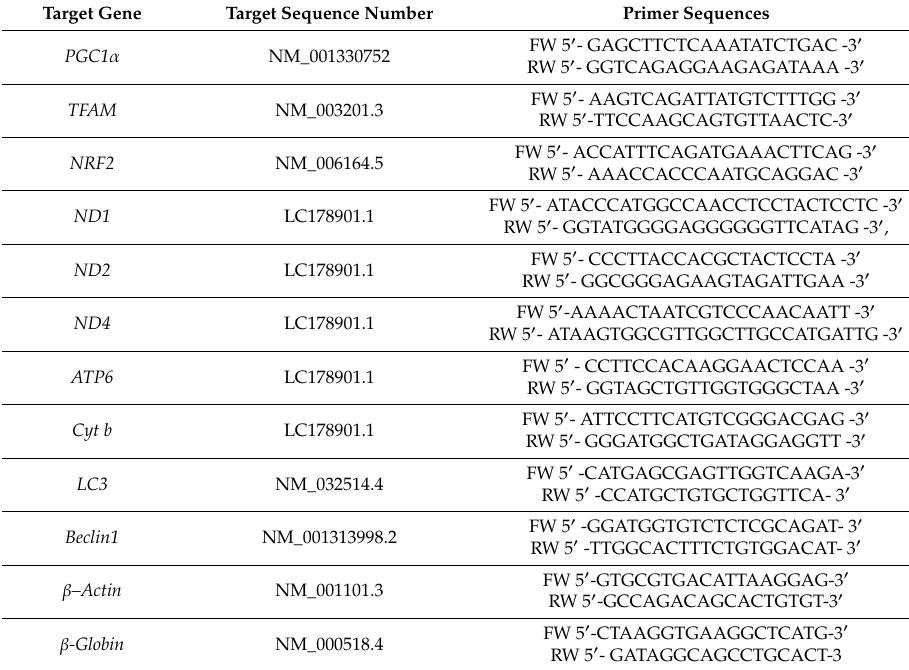
Table 1. Primers used for quantitative Real Time